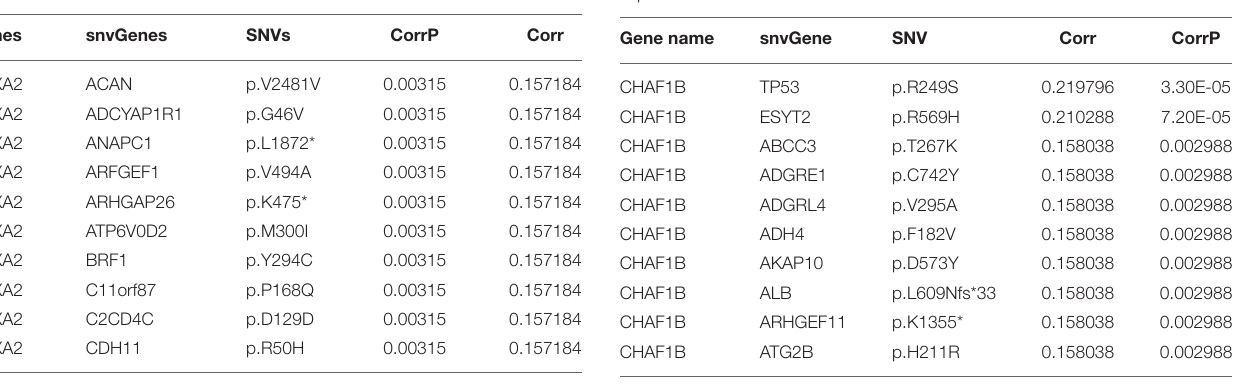
TABLE 4 | The top ten most significant associations between CHAF1B expression and